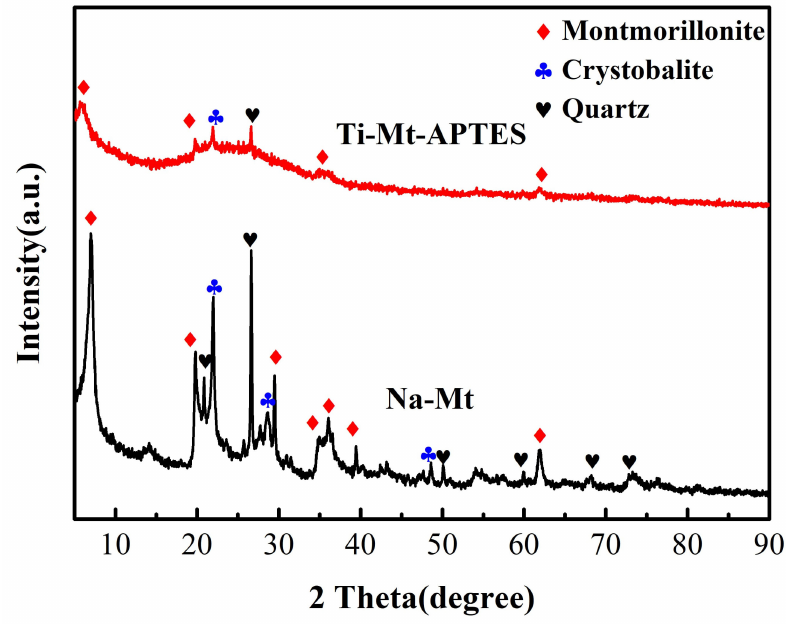
Figure 2. XRD patterns of Na-Mt and